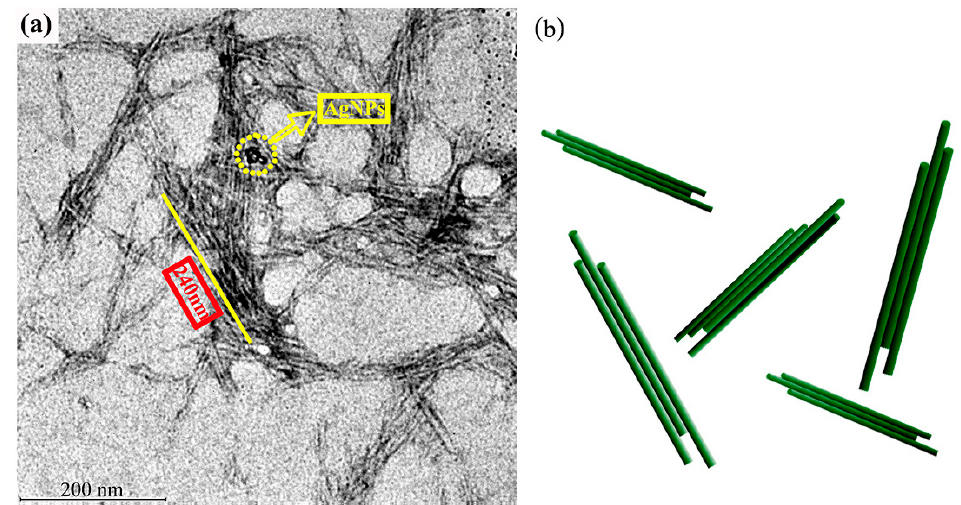
Figure 1. ( a ) TEM image of silver nanoparticles-carboxy-cellulose nanocrystals (AgNPs-CCNC) and ( b ) schematic illustrations of cellulose bundles.